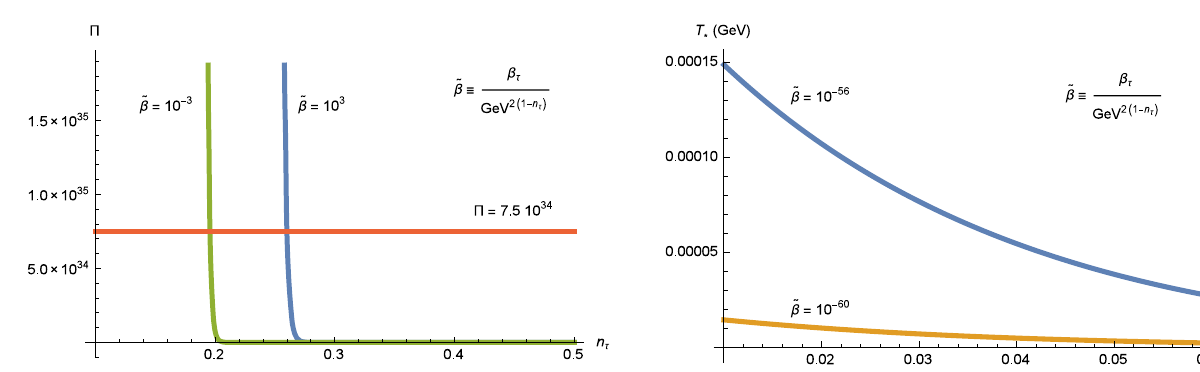
Fig. 3 T ∗ vs n T . The range of n T (cid:5) 0 . 05 is taken from the best fit of CC + H 0 + SNeIa + BAO data. Here ˜ β ∼ ( H 0 / GeV ) 2 ( 1 − n T ) (cid:8) 0 m . The transition temperature occurs at BBN temperature T ∗ ∼ 0 .